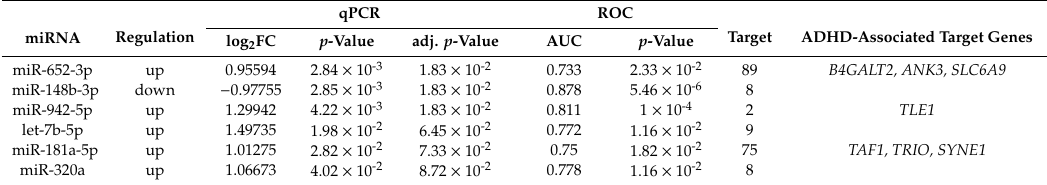
Table 1. List of significant dysregulated miRNAs. For each miRNA, the log 2 FC, p -value, and the corresponding adjusted p -value from qPCR analysis have been detailed. The ROC section shows the results of AUC and associated p -value. The total number of miRNA targets (experimentally validated by reporter gene assays or computationally predicted by at least three algorithms) and the list of previously ADHD-associated target genes have been